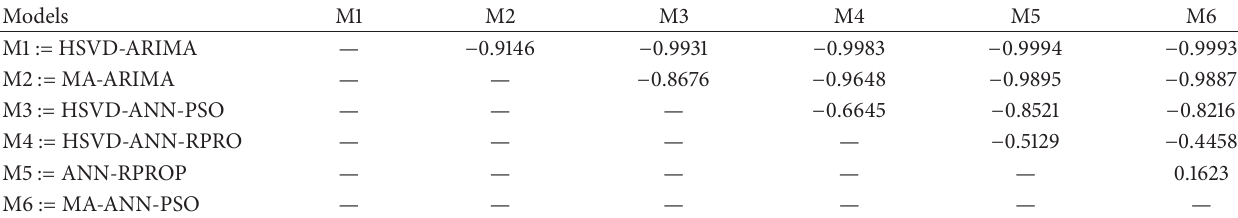
Table 4: Pitman’s correlation (Corr) for pairwise comparison six models at 5 % of significance and the critical value 0.2219.